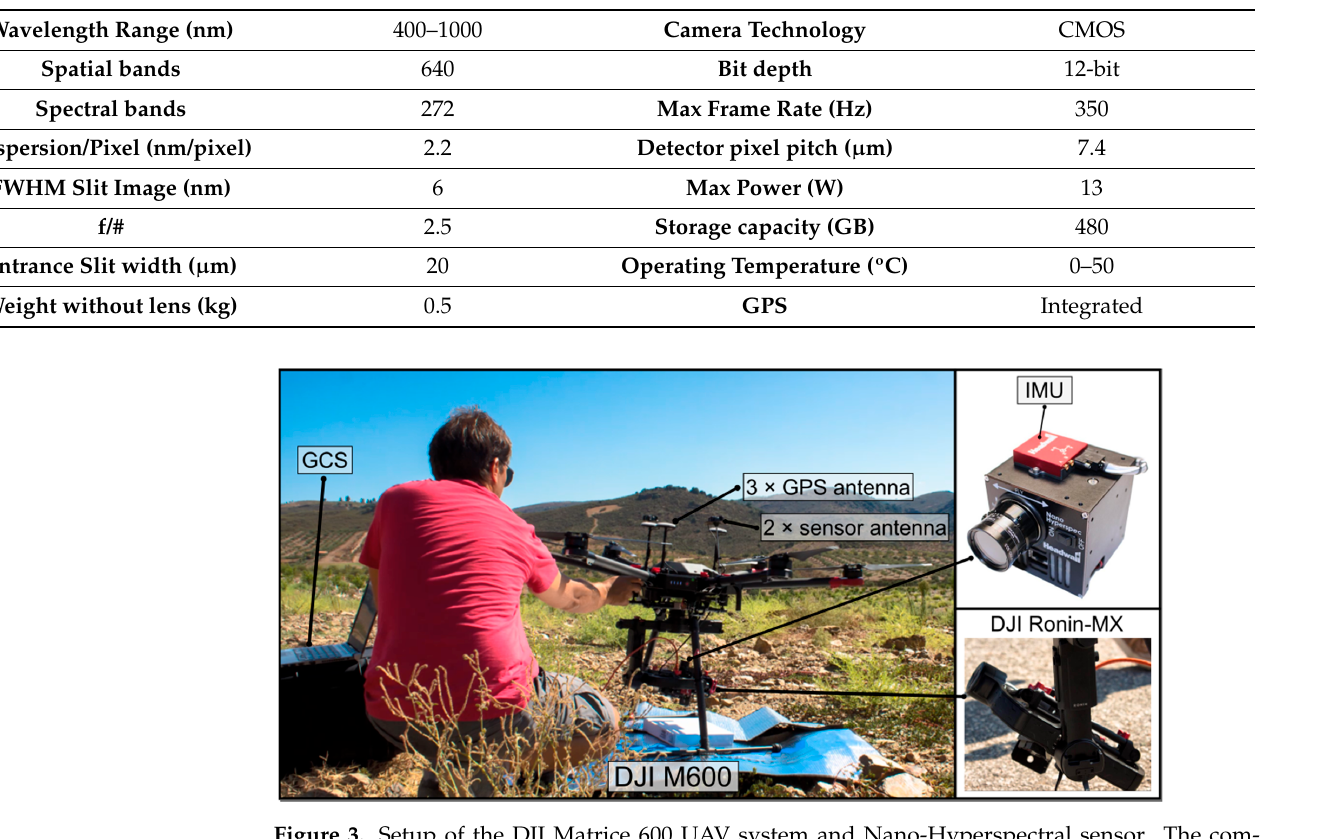
Table 2. Nano-Hyperspec sensor specifications.